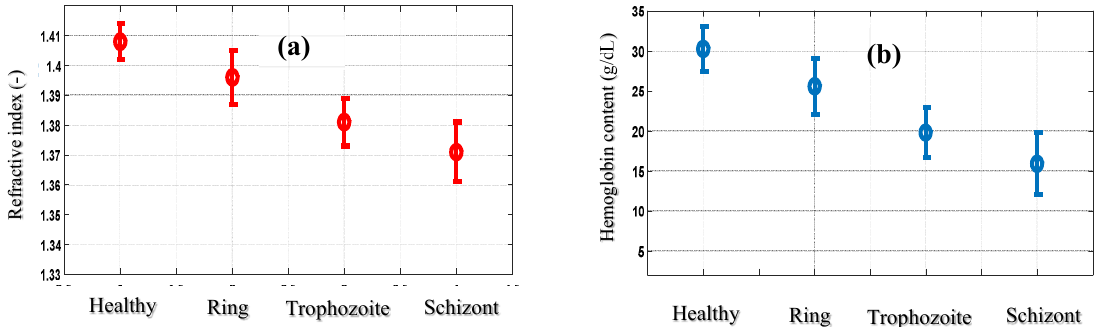
Figure 12. The refractive index of RBCs ( a ) and hemoglobin content ( b ) for the different stages of infection.